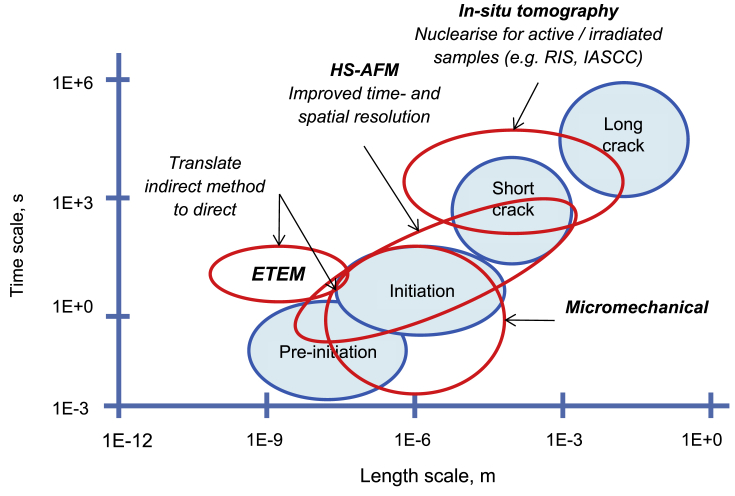
Opportunities where selected techniques6 could be applied in micro-scale testing of EAC/SCC.